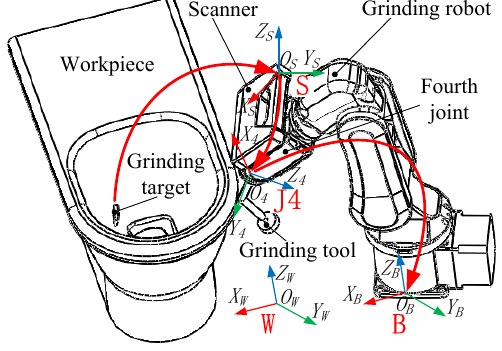
Figure 1. Schematic diagram of the grinding robot 3D vision